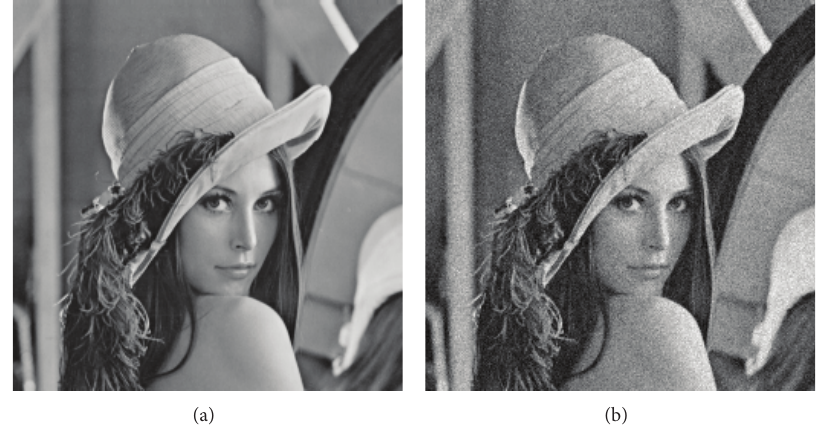
Figure 1: (a) Original image; (b) noisy image. Table 1: Execution time for deriving Figures